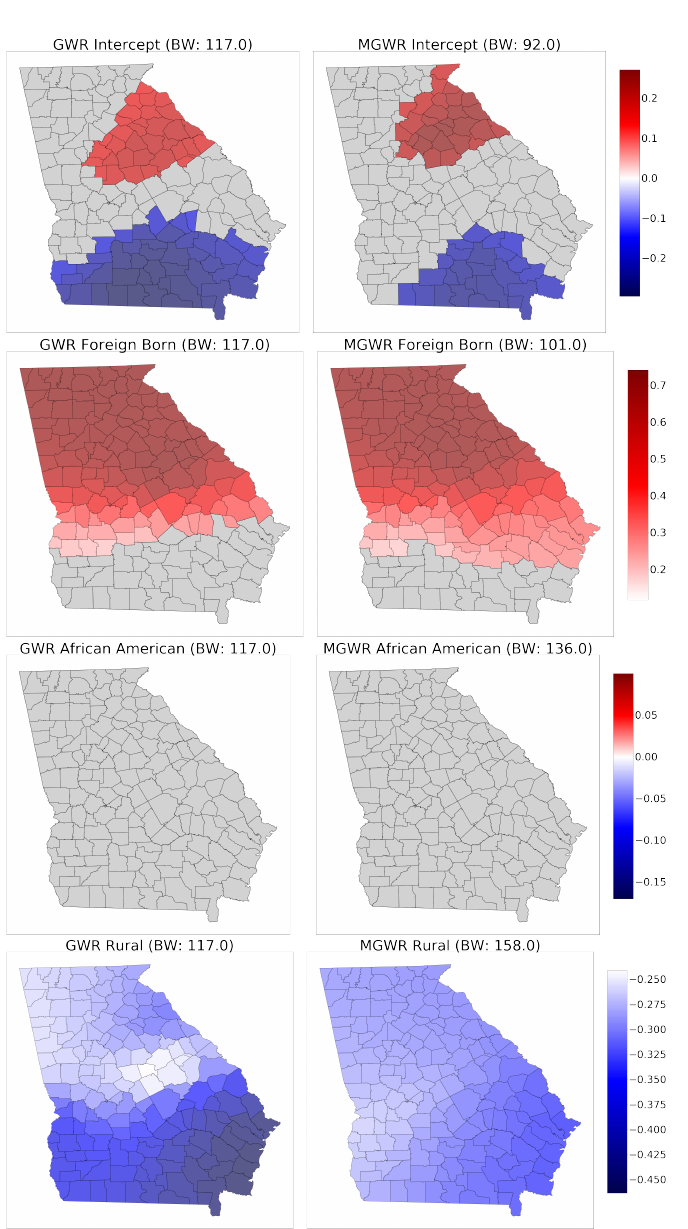
Figure 12. Parameter estimates for geographically weighted regression (GWR) ( left ) and multiscale GWR (MGWR) ( right ) for Georgia